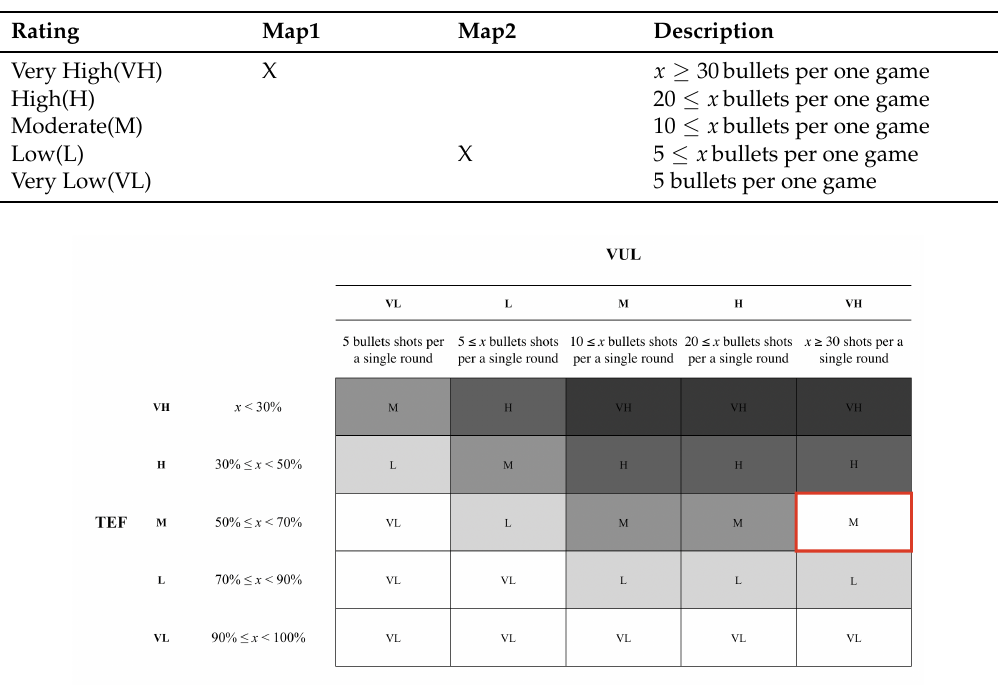
Figure 5. The heat map for Map1 was assigned a ‘Moderate’ grade based on the participants’ response on the TEF and